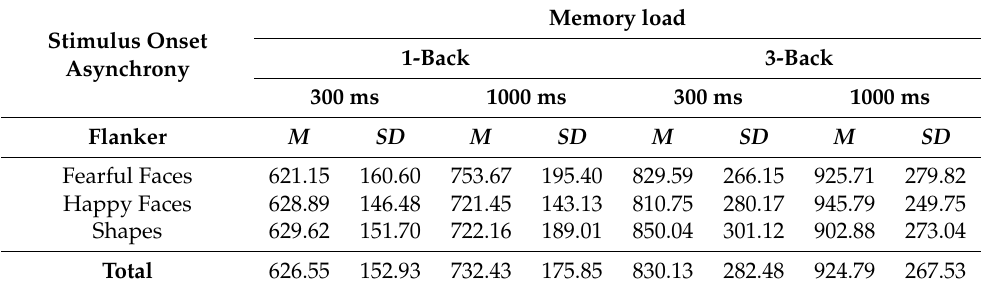
Table 15. Means and SDs of participants’ correct rejection reaction times for Study